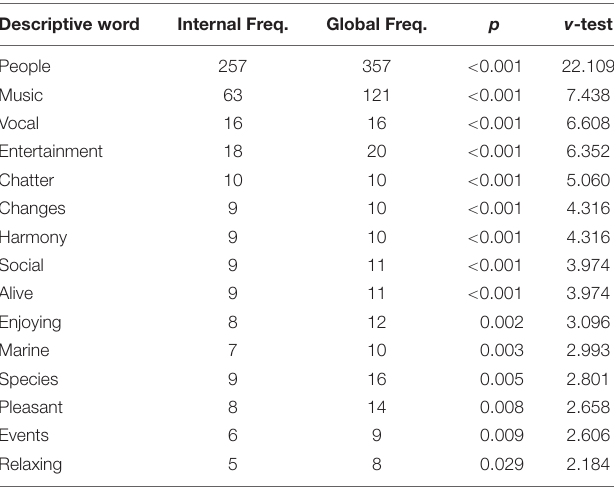
TABLE 2 | Descriptive words that were significantly over-represented in the first cluster of the soundscape categorization data. Descriptive word Internal Freq.